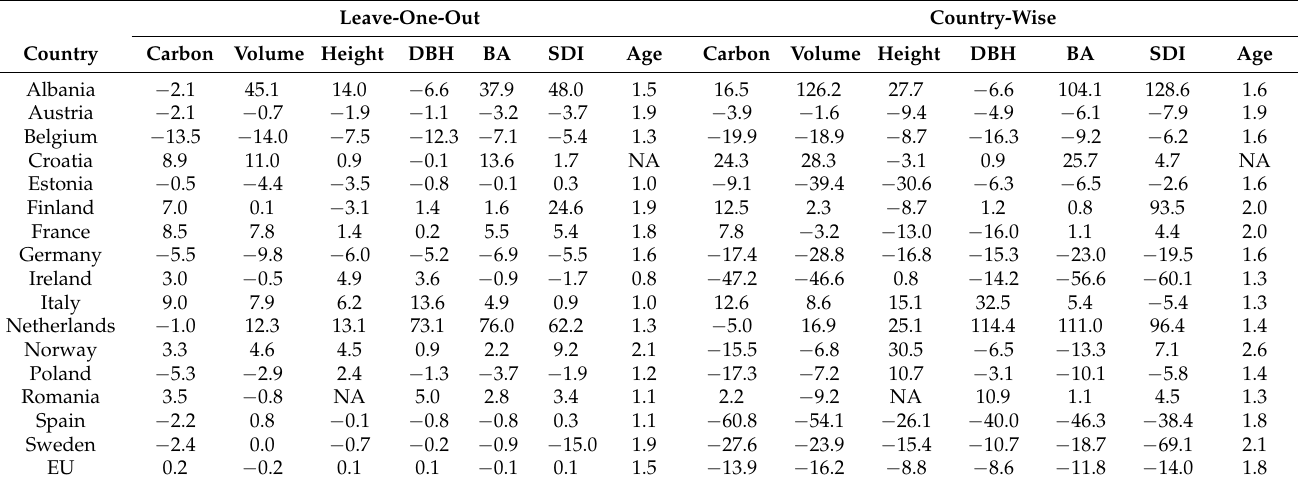
Table 3. Cross validation results by country. We show here the median of the percentage relative difference to the input gridded terrestrial data values for carbon content in tons of live tree carbon per hectare (Carbon), volume in m 3 /ha, height in m, diameter in breast height (DBH) in cm, basal area (BA) in m 2 /ha and stand density index (SDI). Age class (Age) is given as the mean of the absolute most frequent age class difference between cross validation and gridded terrestrial values. Negative values indicate an underestimation in the algorithm. For full names and units of forest structure variables, see Table 2. NA indicates that these data are missing for this